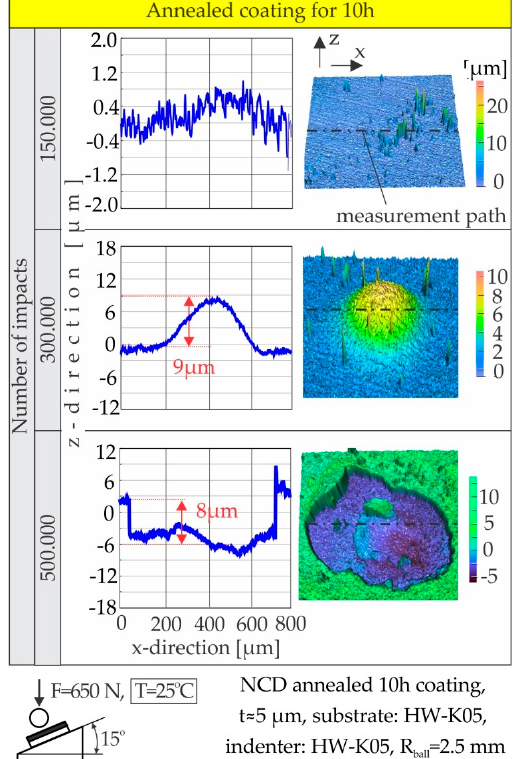
Figure 8. Impact test results on the annealed NCD coated inserts for 3 h at an impact load of 600 N after various number of impacts. Coatings 2020 , 10 , x FOR PEER REVIEW